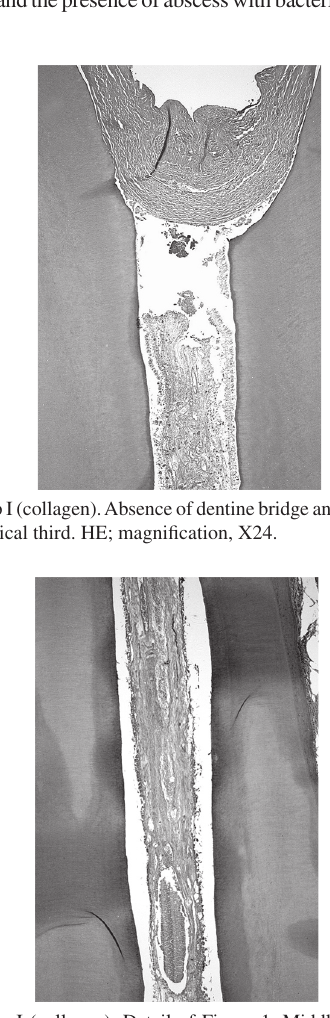
Figure 2. Group I (collagen). Detail of Figure 1. Middle third with tissue degeneration, fibrosis and areas of necrosis. HE; magnification,